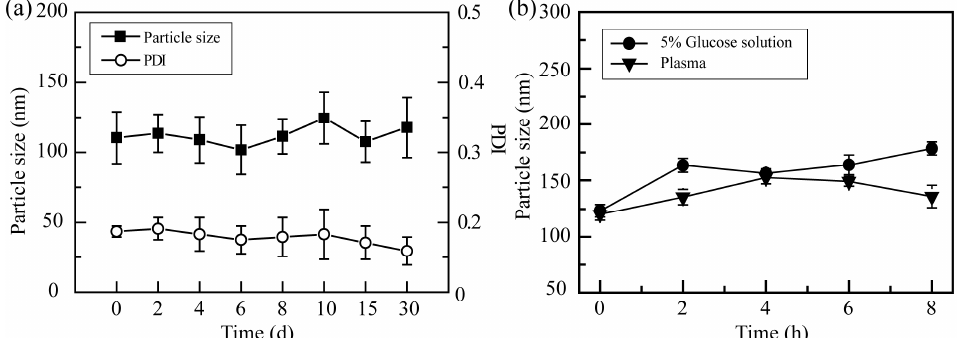
Figure 3. Particle size of α-PGA/DOX NPs in deionized water placed at 4 °C for 30 days ( a ); stability of α-PGA/DOX NPs in 5% glucose solution and plasma ( b ) ( n = 3). of α -PGA/DOX NPs in 5% glucose solution and plasma ( b ) ( n =